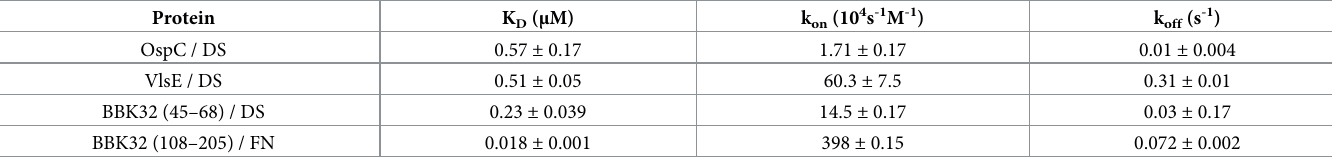
Table 3. Comparison of ligand binding parameters for OspC, VlsE and BBK32. The values noted are for proteins from B . burgdorferi B31 and are taken from the fol- lowing sources: OspC, [14]; VlsE, this work; BBK32 (residues 45–68) and BBK32 (residues 108–205), [49]. The BBK32 proteins that were included for the kinetic parame- ters here are the fragments of the amino acids 45–68 and 108–205, which are the DS- and FN-binding domains of BBK32.